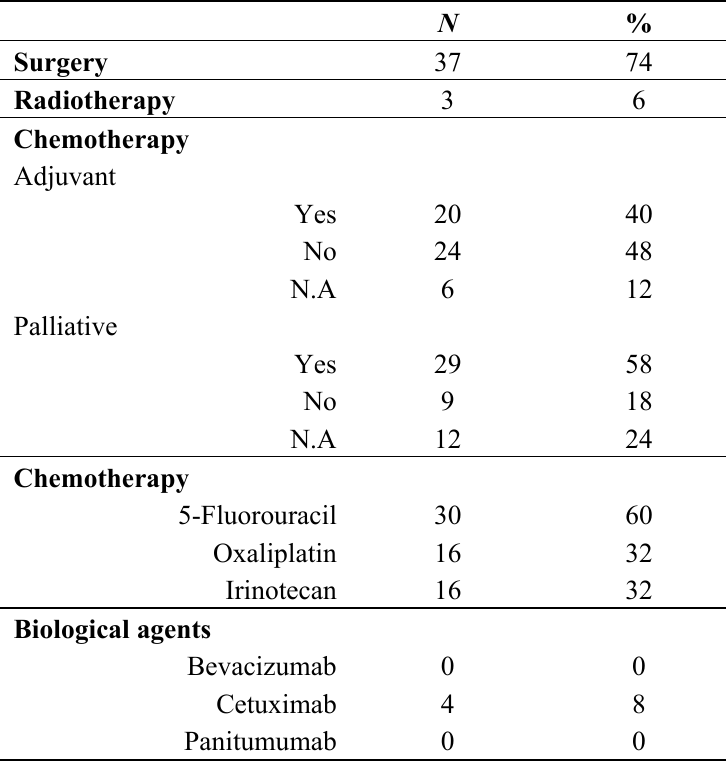
Table 2. Pre-neurosurgical treatments.